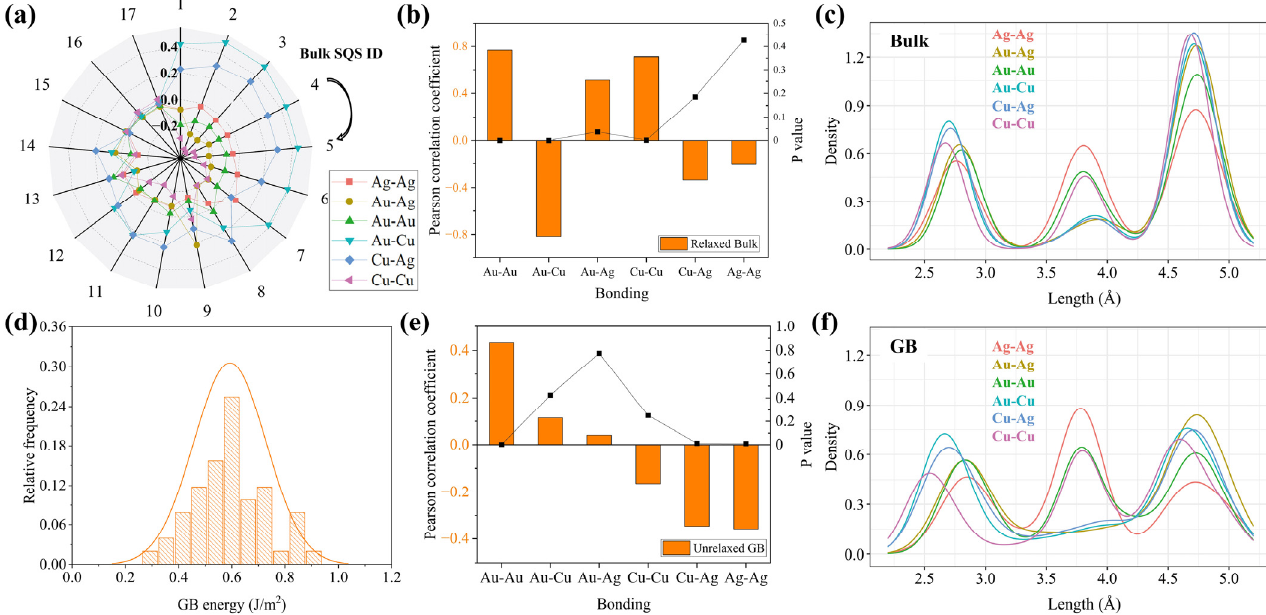
Figure 6. The DFT calculation of the phase-transition characteristics. ( a ) The chemical SRO in the bulk supercells. ( b ) The correlation between the number of bonds and total energies of the relaxed bulk supercells. ( c ) The bond length distributions in the relaxed bulk supercells. ( d ) The distribution of GB energies. ( e ) The correlation between the number of bonds in the GB region and the GB energy before structural relaxations. ( f ) The bond length distributions in the GB regions.